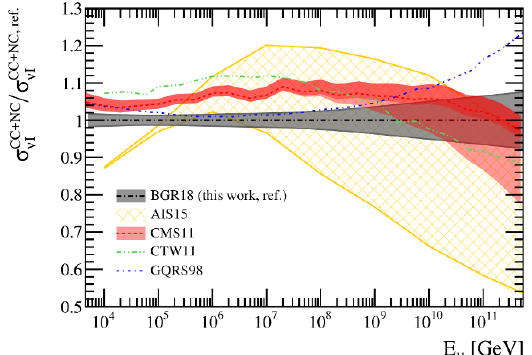
Figure 15 . Same as (cid:12)gure 14, now for the sum of NC and CC neutrino-isoscalar cross-sections. In addition, the AIS15 calculation based upon the non-linear QCD (saturation) framework is